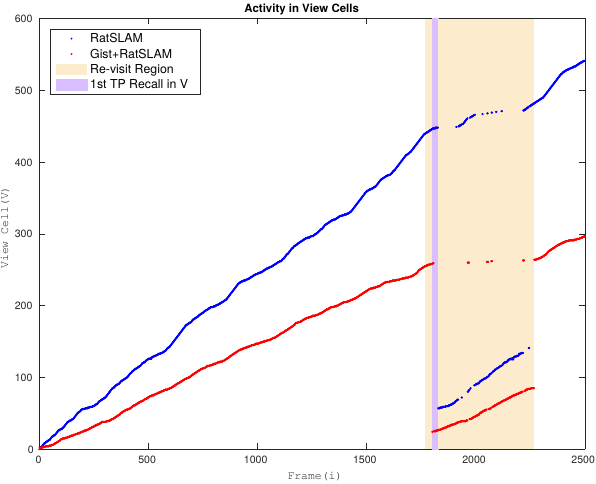
Figure 4: Activity in view cells for traversing un- visited and visited places. Gist+RatSLAM (our ap- proach) needs fewer view cells and has more true positive recalls compared to RatSLAM (blue